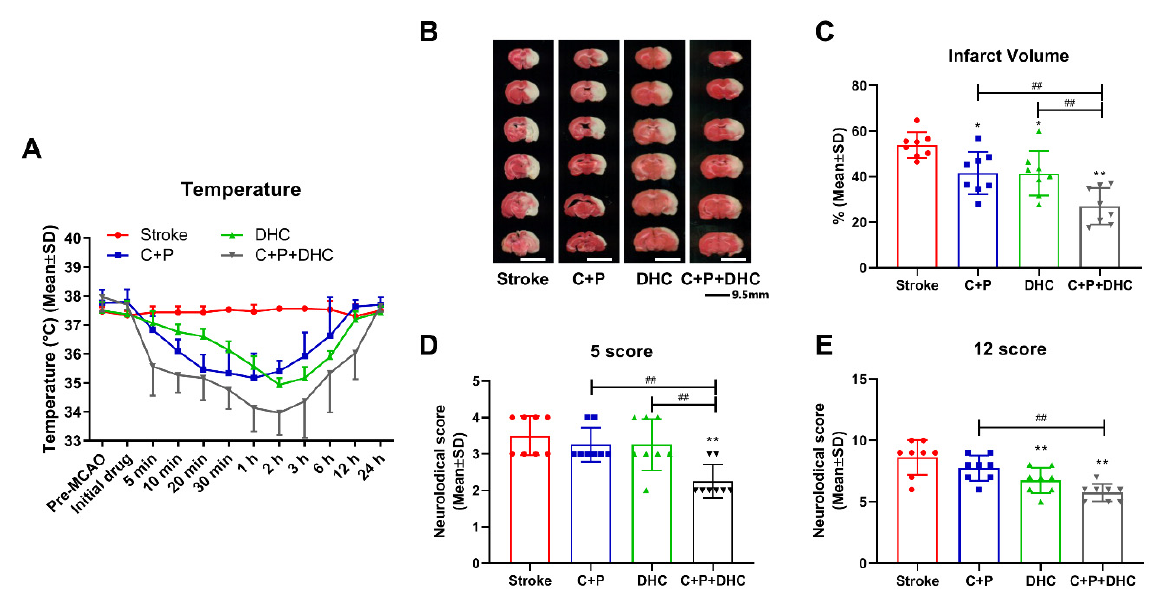
Figure 1. Induction of pharmacological hypothermia and its neuroprotective effects in rat MCAO models. ( A ) Body temperature before and after the model development with different treatments. Body temperature reached the lowest target of 35.2 °C by C + P, 34.9 °C by DHC, and 34 °C by C + P + DHC. ( B ) Representative brain slices stained with TTC after 2 h MCAO and 48 h of reperfusion. ( C ) Graphic quantification of TTC sections revealing that C + P + DHC result in significantly de-